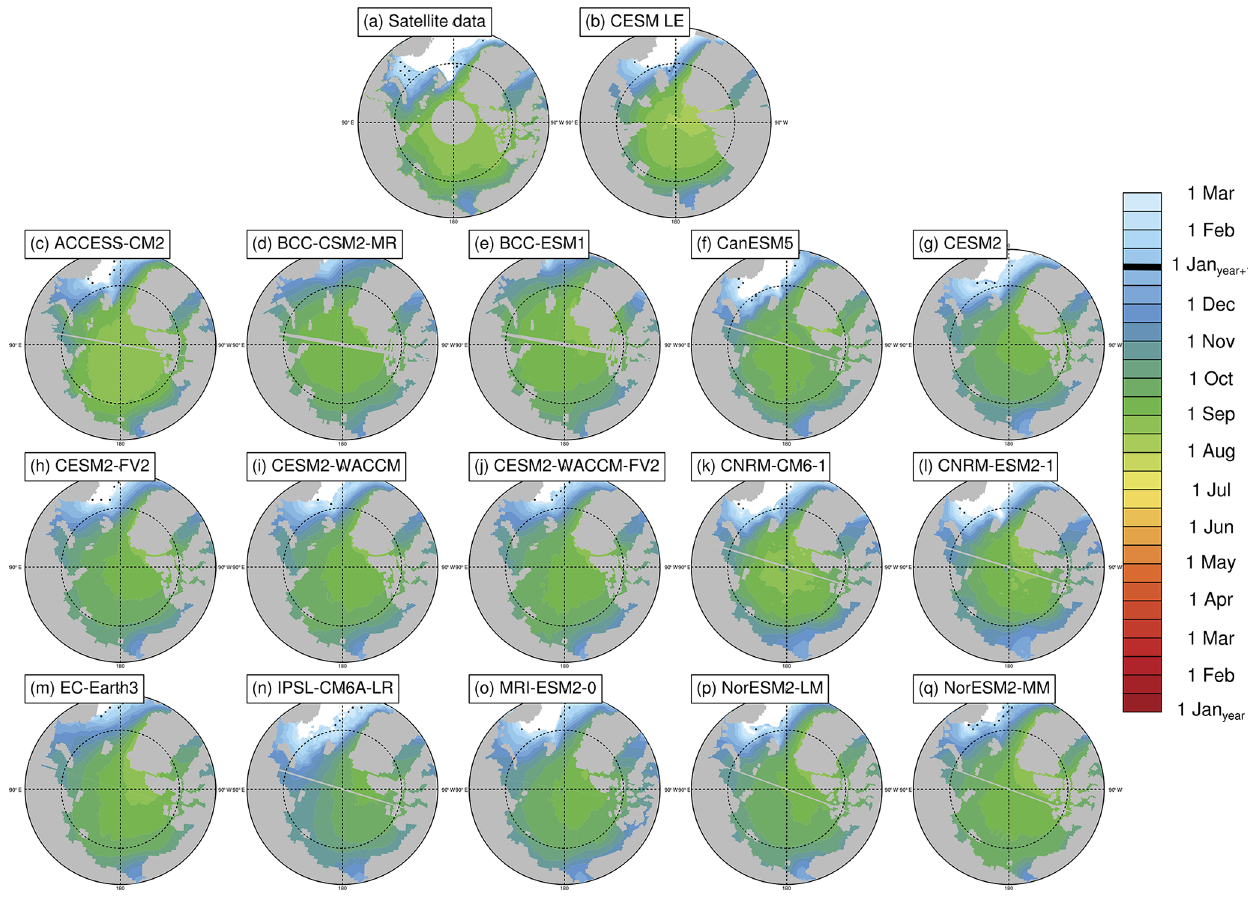
Figure 5. Freeze onset dates (defined using surface temperature in the models and brightness temperatures in the satellite data) averaged over the period 1979–2014 at each grid cell using satellite data (a) , the first ensemble member of the CESM LE (b) , and the first ensemble member of each CMIP6 model (c–q) . Stippling indicates where freeze onset dates exist in less than 20% of years in the time range. Models on tripolar grids produce plot gaps filled by gray